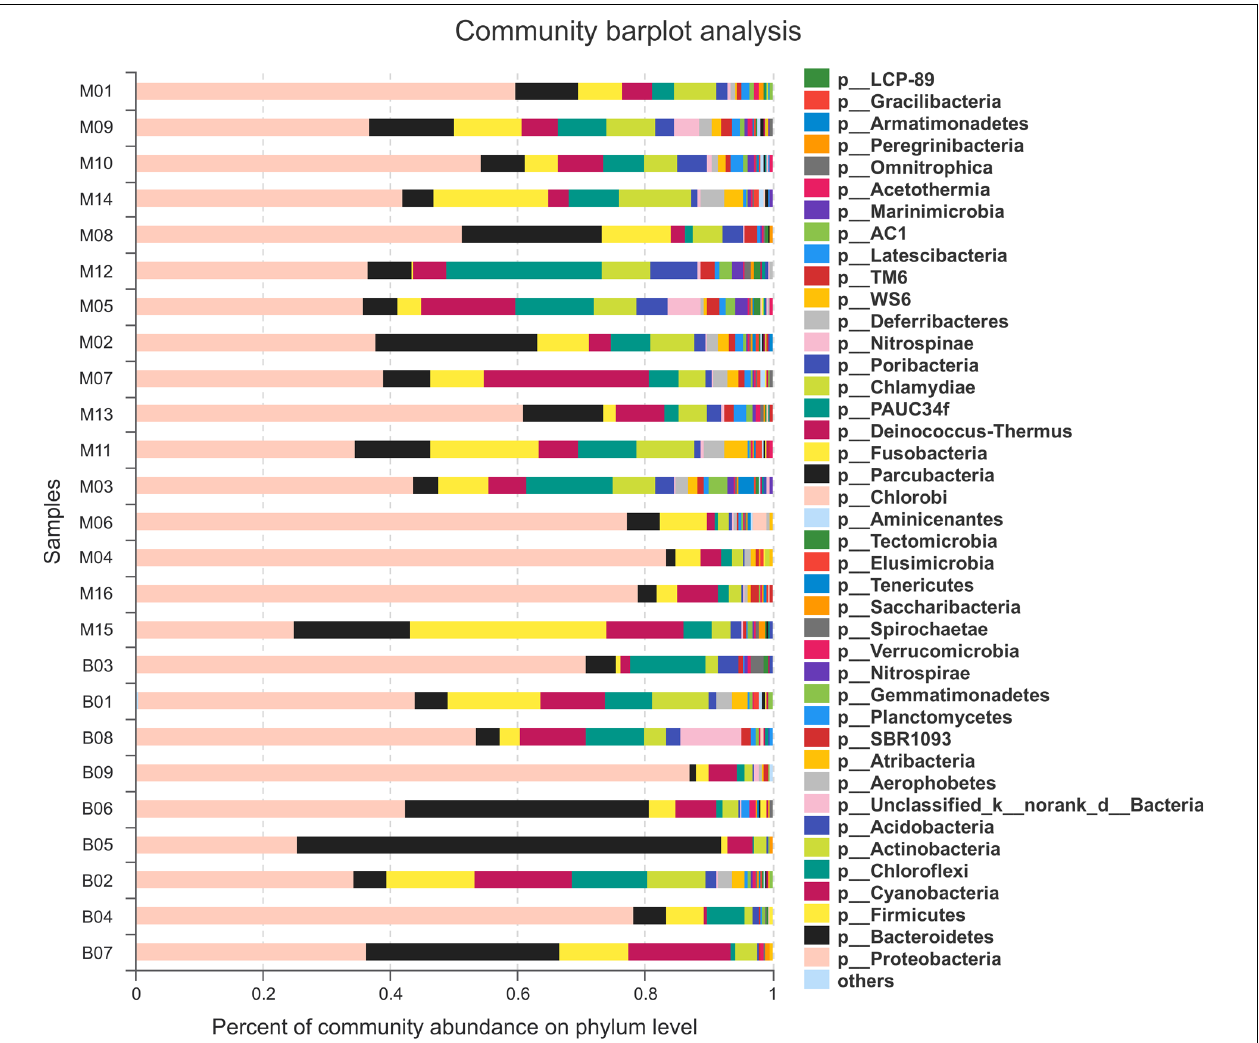
FIGURE 2 | Bacterial composition profiles. Taxonomic classification of bacterial reads retrieved from different coral species at phylum level using RDP classifier. “others” represent the bacterial phyla with abundances of less than